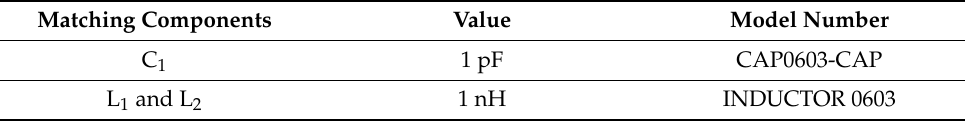
Table 2. Summary of the Used Matching Network Components.